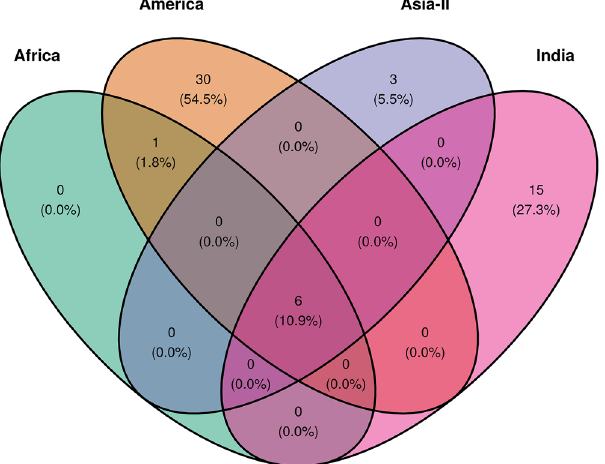
Figure 4. Shared polymorphisms in partial mtCOIA gene for FAW populations across the four geographical groups viz. America, Africa, India and Asia-II. The figure was made with the help of R package tidyverse v 1.3.0 and ggvenn v 0.1.8 24,27